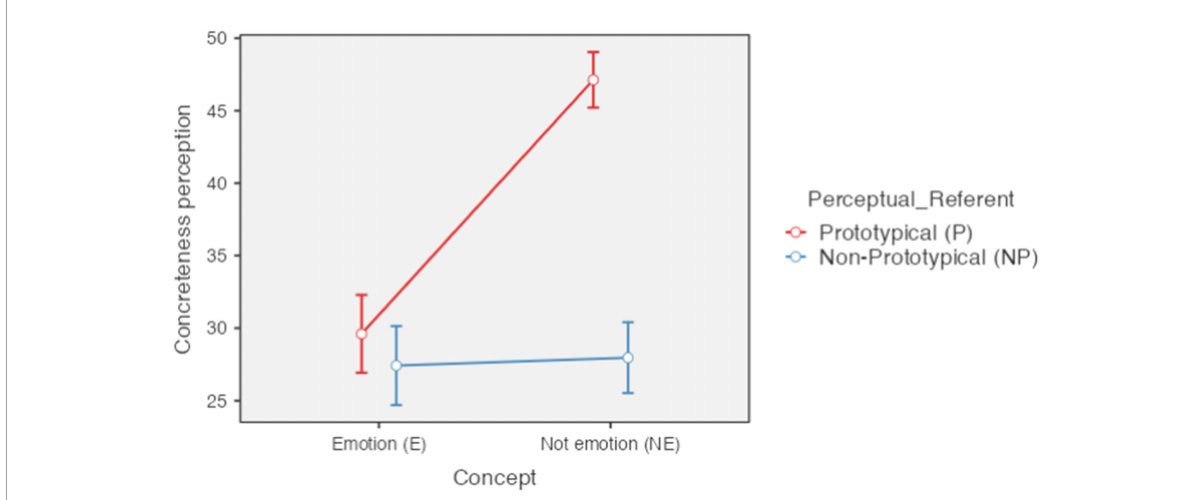
FIGURE1 Perception of concreteness according to type of concept and type of perceptual referent. Error bars 95% CI; significant differences between concepts of, basic emotion and concrete (E-P_NE-P > ; secondary emotion and concrete (E-NP_NE-P); concrete and abstract (NE-P_NE-NP). P < 0.001. Created with Jamovi